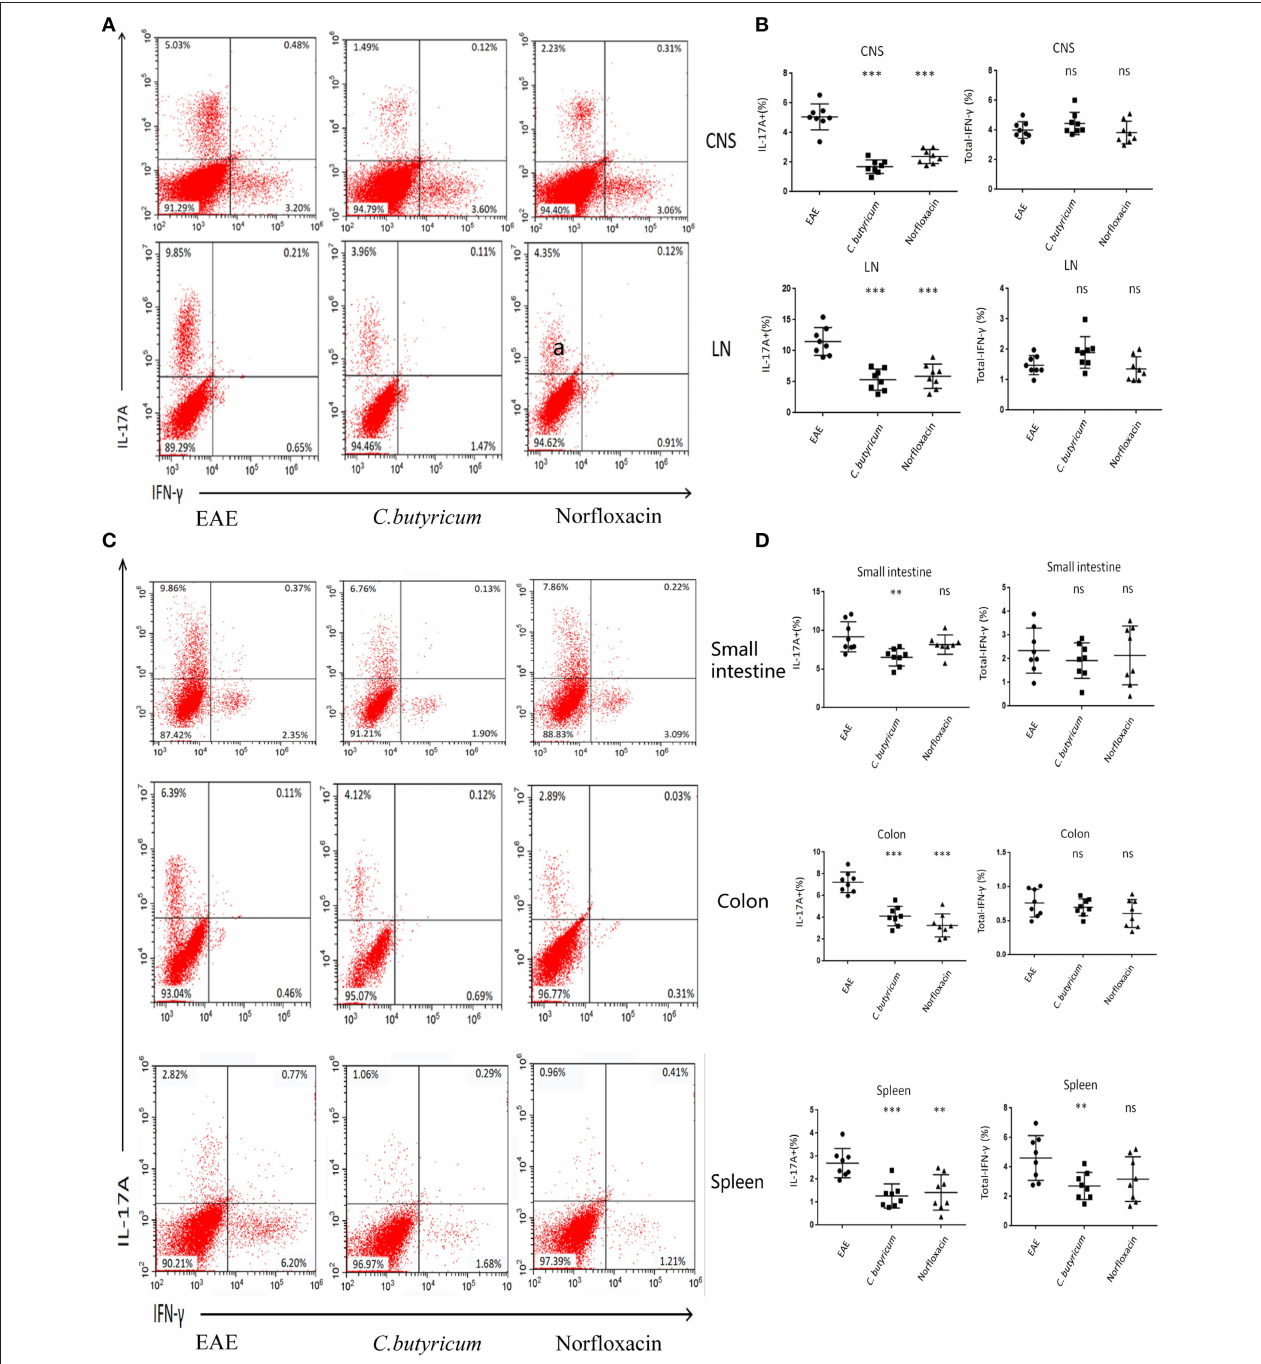
FIGURE 4 | Gut microbiota intervention diminish Th17 responses in EAE. Lymphocytes from CNS, LN, small intestine, colon, and spleen were isolated 21 days post immunization and used for assessment of different CD4T cell subsets. (A) Representative staining of different CD4T cell subsets in CNS and LN, gated on TCR β + CD4 + . (B) Statistical analysis of the percentages of IL-17 and IFN- γ in (A) . Representative staining (D) and statistical analysis (C) of IL-17 and IFN- γ in CD4T cells isolated from small intestine, colon, and spleen of mice, gated on TCR β + CD4 + . Statistically significant data are indicated by asterisks (** P < 0.01 and *** P < 0.001). ns, not